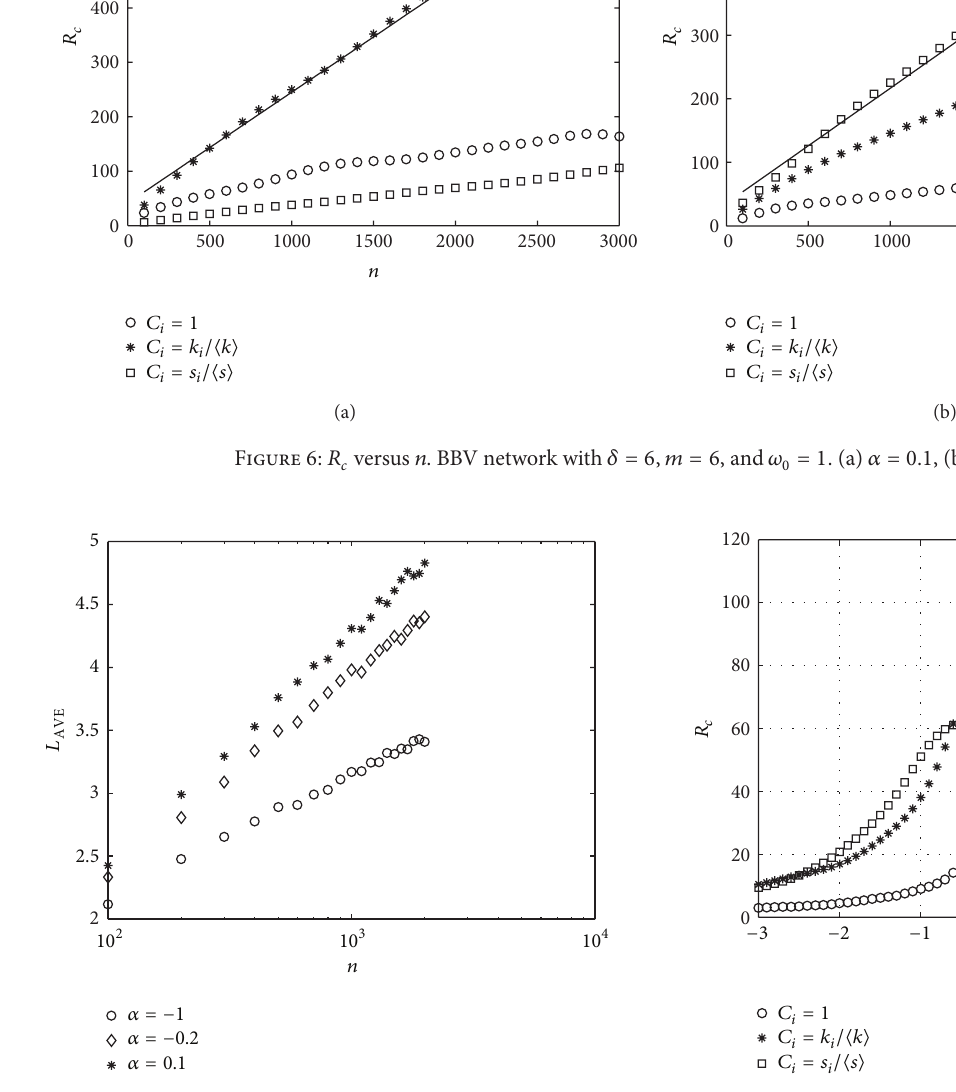
Figure 8: 𝑅 𝑐 versus 𝛼 . Real-world